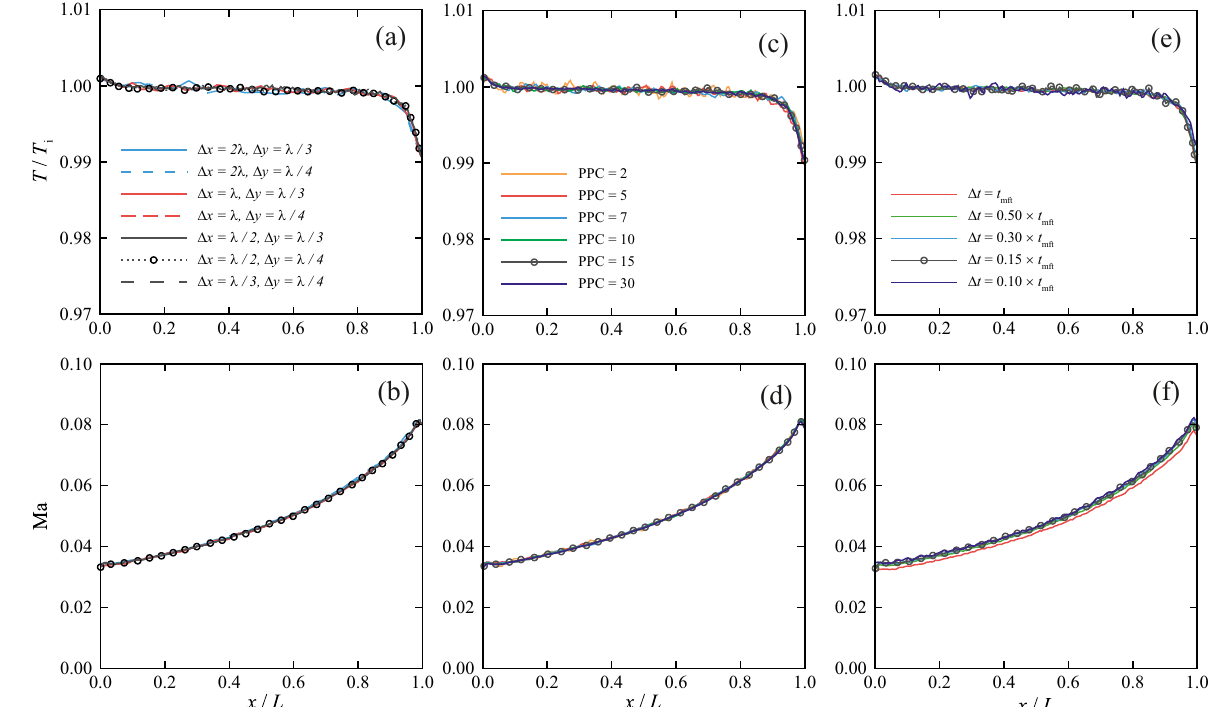
Figure 3. The effects of ( a , b ) the computational grid size, ( c , d ) number of simulator particles per cell, and ( e , f ) time-step size on the predicted profiles of temperature and Mach number along the channel centreline. Kn i = 0.1, φ = 1 and Π = 2.5. Curves shown with symbols indicate the chosen